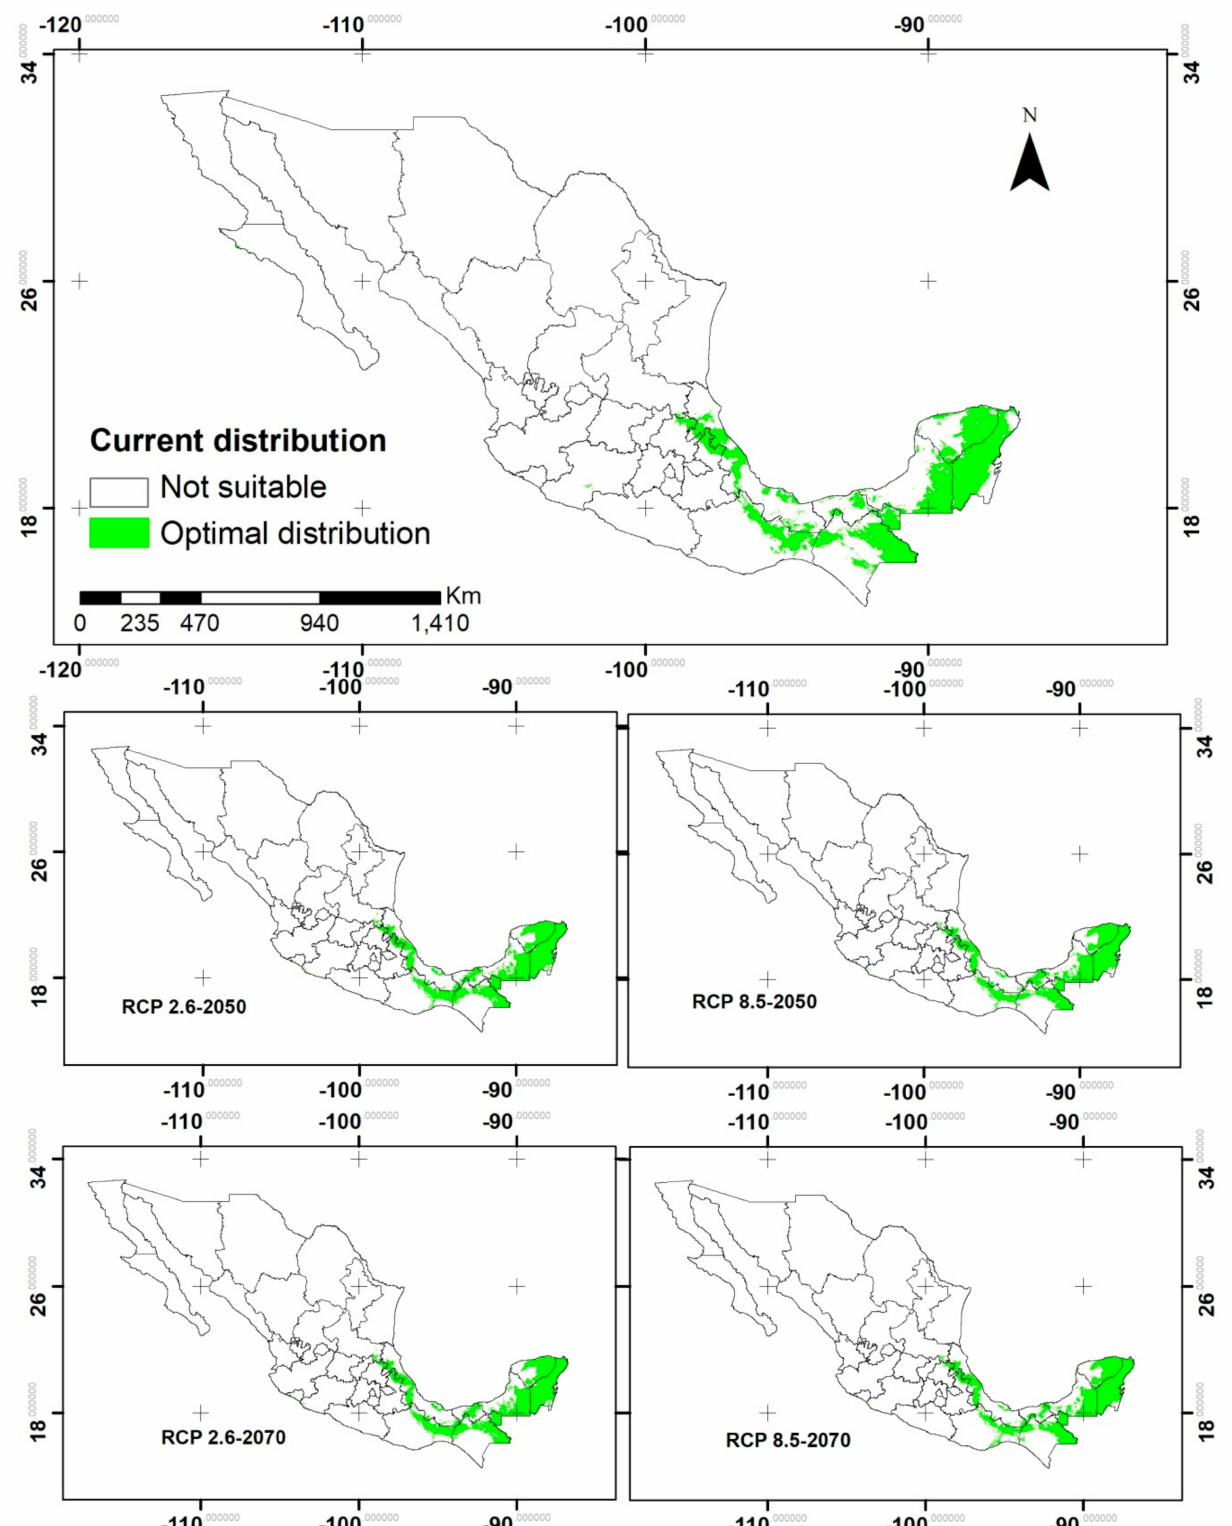
Figure 6. Potential distribution of S. macrophylla , currently and projected for 2050 and 2070 under the RCP2.6 and RCP8.5 in the CCSM4